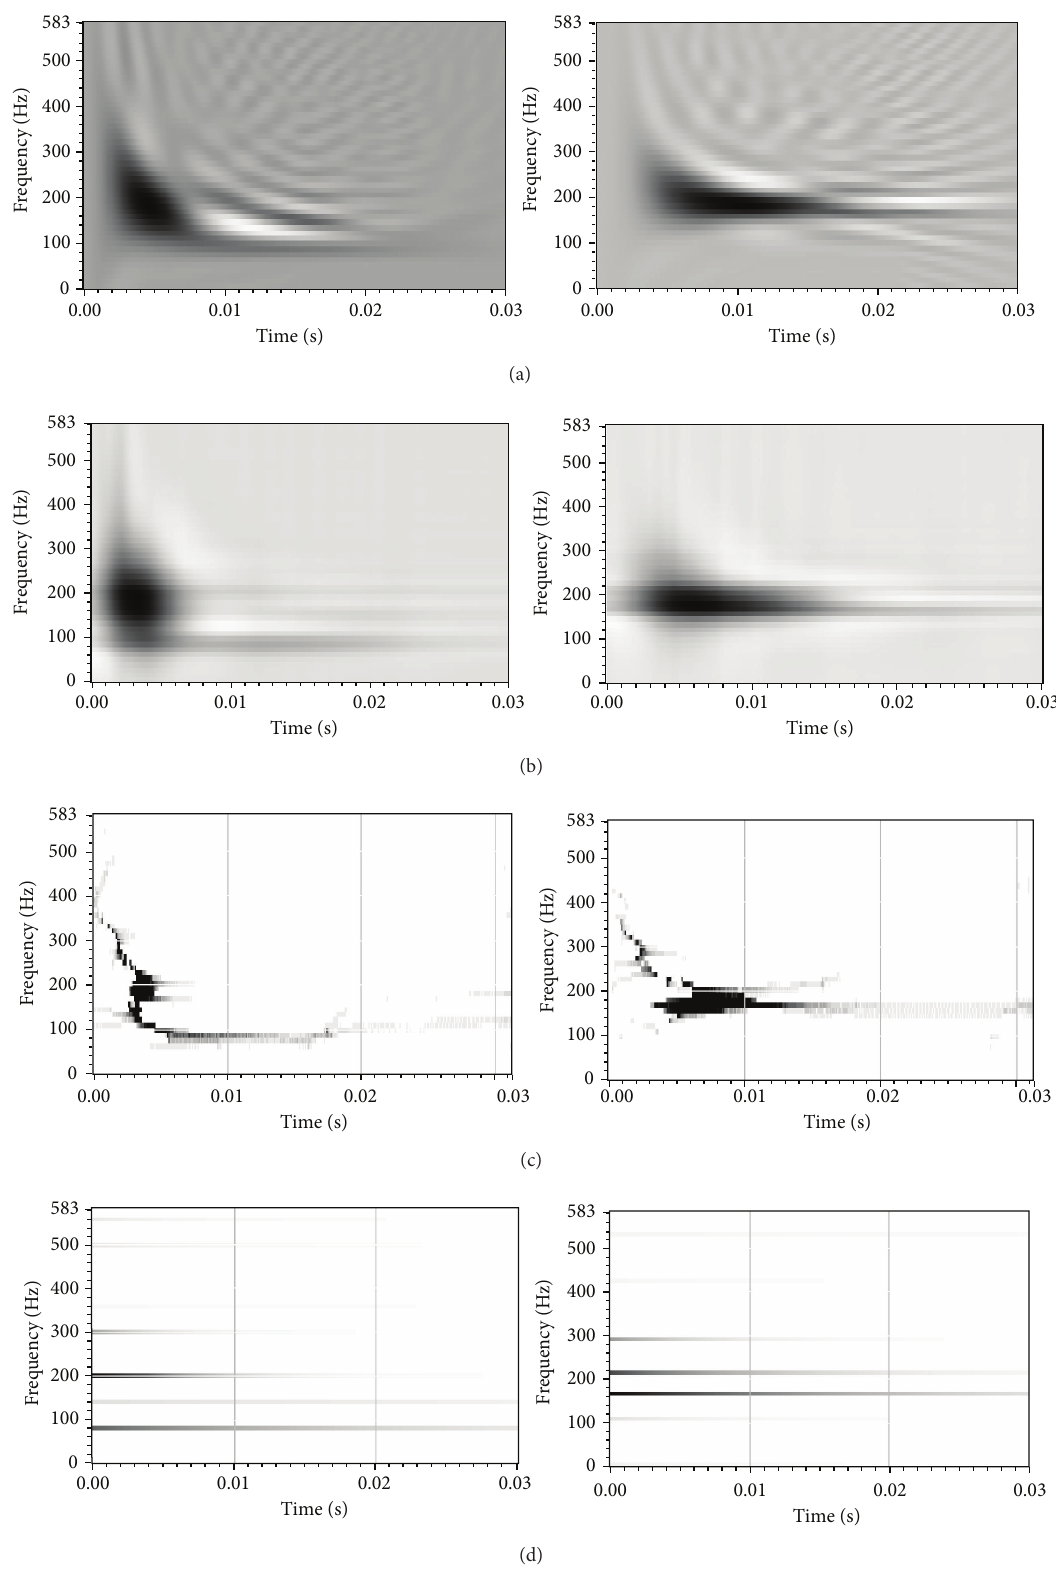
Figure 2: Time-frequency representations of the chest and abdominal percussion signals of Figure 1. (a) WVD; (b) CWD ( 𝛼 = 0.8 ); (c) STFT (spectrograms) taken with 1400-point Gaussian window; (d) MPM TFR (amplitudes of all EDS extracted from both